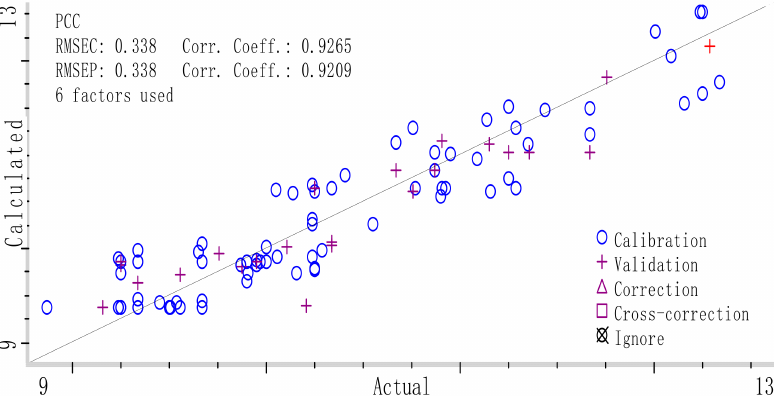
Figure 8. Reference measured versus NIR prediction by synergy interval partial least squares (Si-PLS) in calibration and prediction set of G. elata